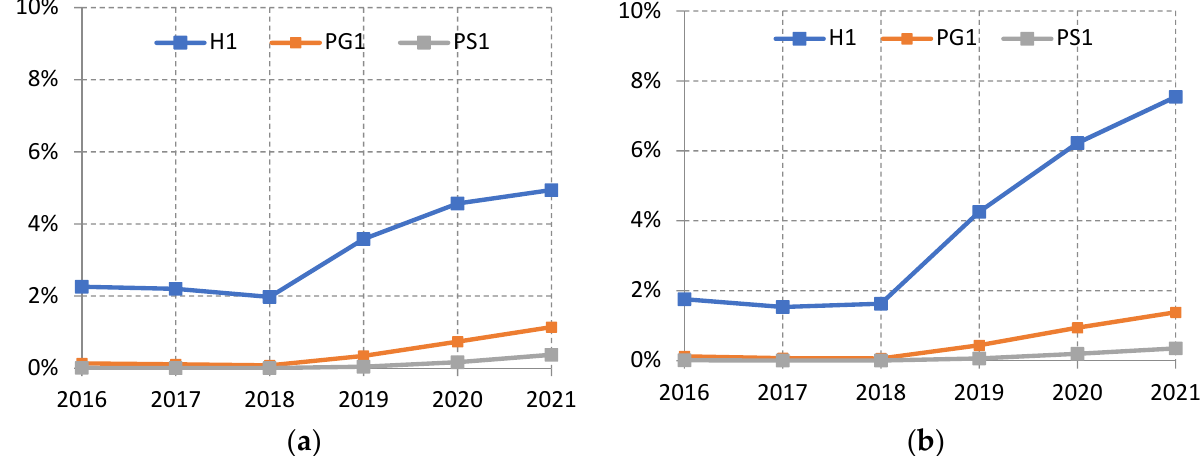
Figure 2. Intertemporal calculations of absolute poverty: ( a ) rural resettled; ( b ) urban resettled.